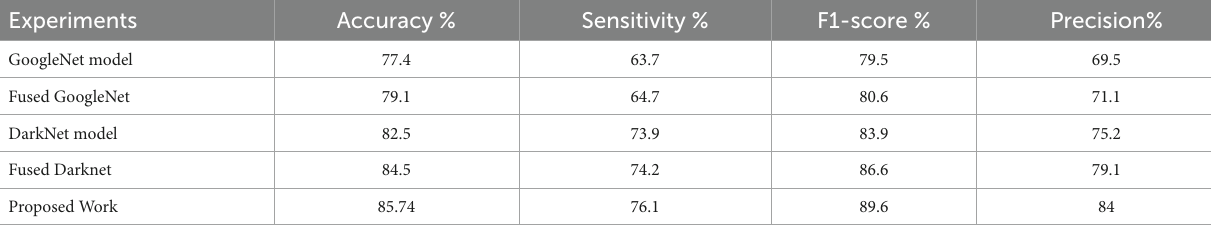
TABLE 7 Overall average performance under the two experiments.